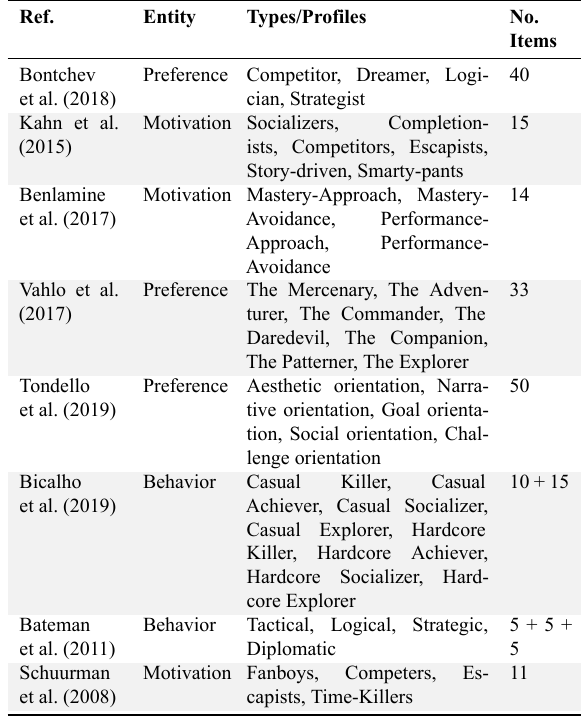
Table 3. Studies that proposed instruments to help identify players’